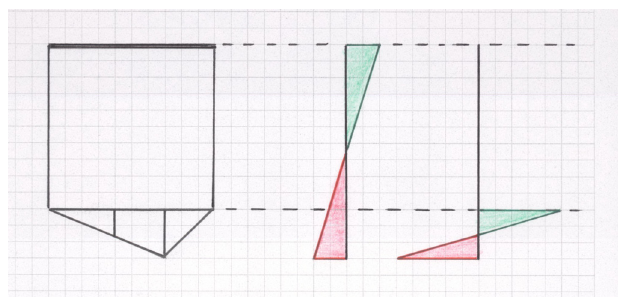
Figure 4: left: sketch of the walkway section with the triangular box girder, the glass walls and the roof plate; middle: bending stesses/strains for the complete section; right: bending stresses/strains if the box girder solely reacts to bending – this is what we wanted to achieve.